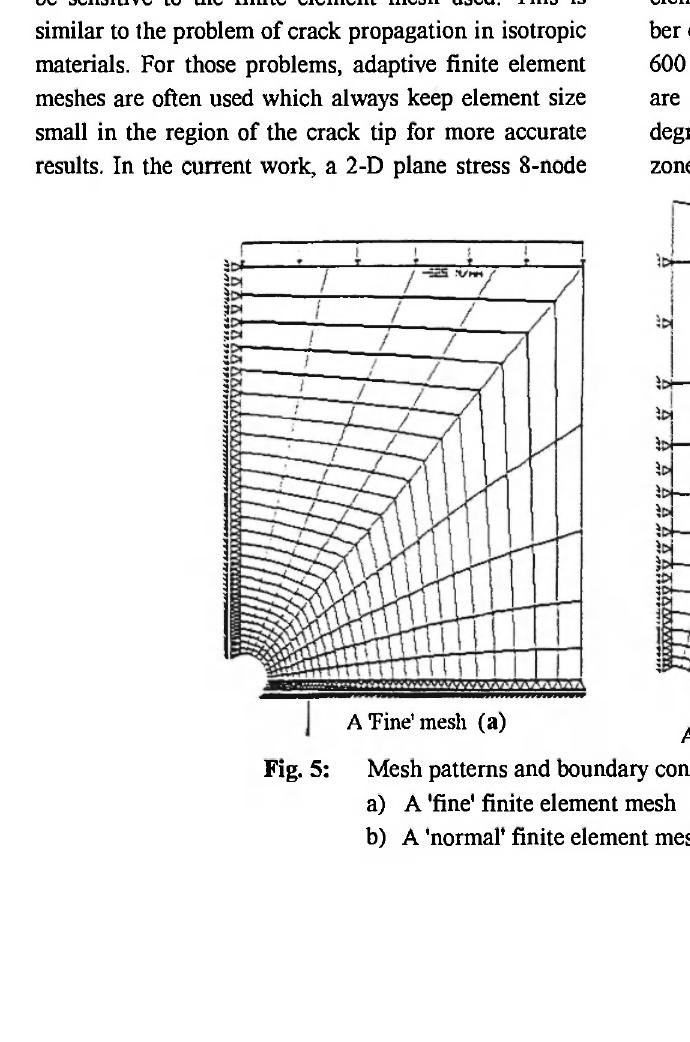
Fig. 5: Mesh patterns and boundary conditions used in the FE analysis. a) A 'fine' finite element mesh b) A 'normal' finite element